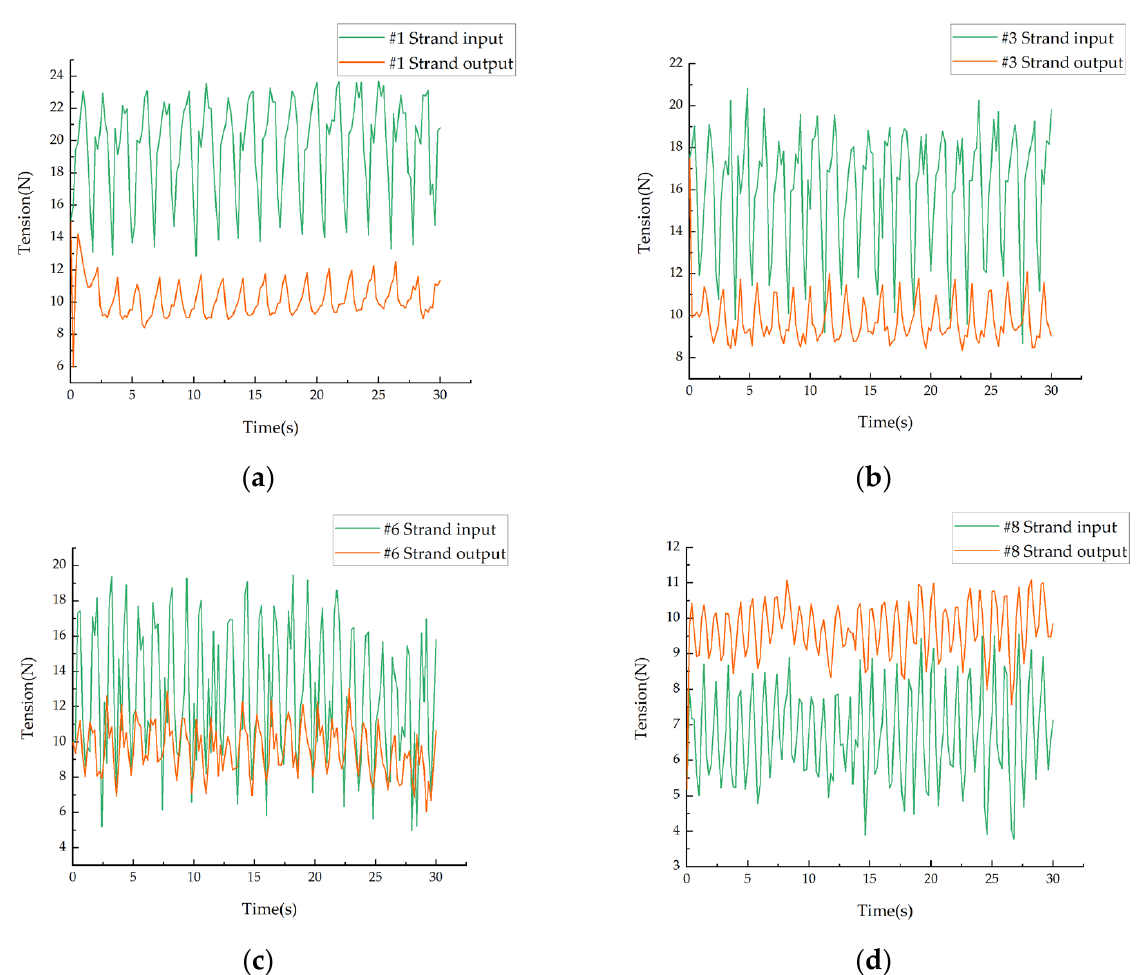
Figure 11. Comparison of tension of each strand before and after tension control: ( a ) comparison of #1 strand tension; ( b ) comparison of #3 strand tension; ( c ) comparison of #6 strand tension; and ( d ) comparison of #8 strand tension.